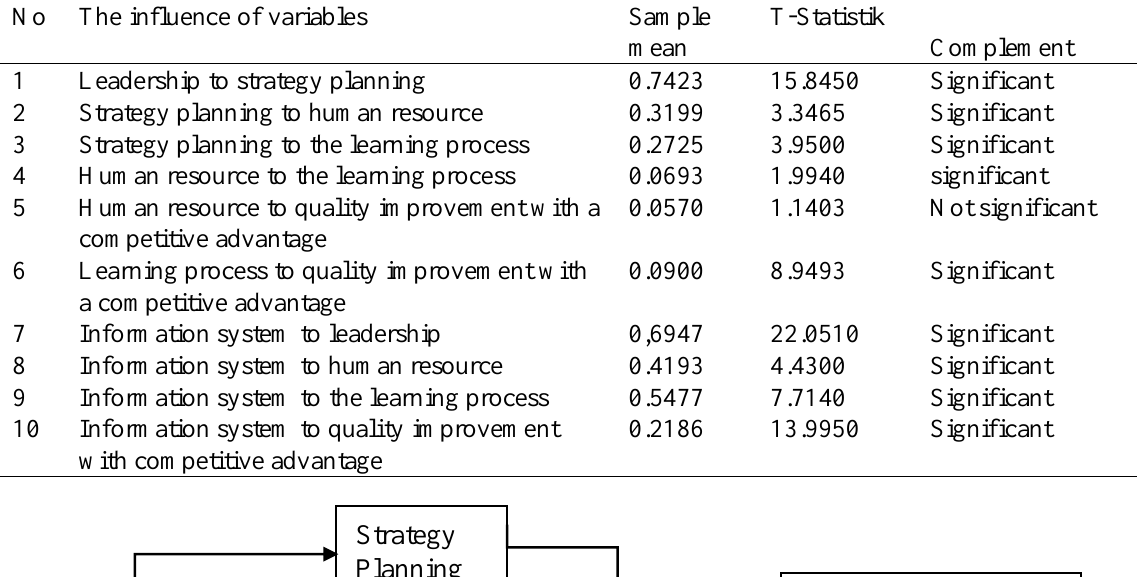
Table 4. The test of the influence of variables with Partial Least Square (PLS) test No